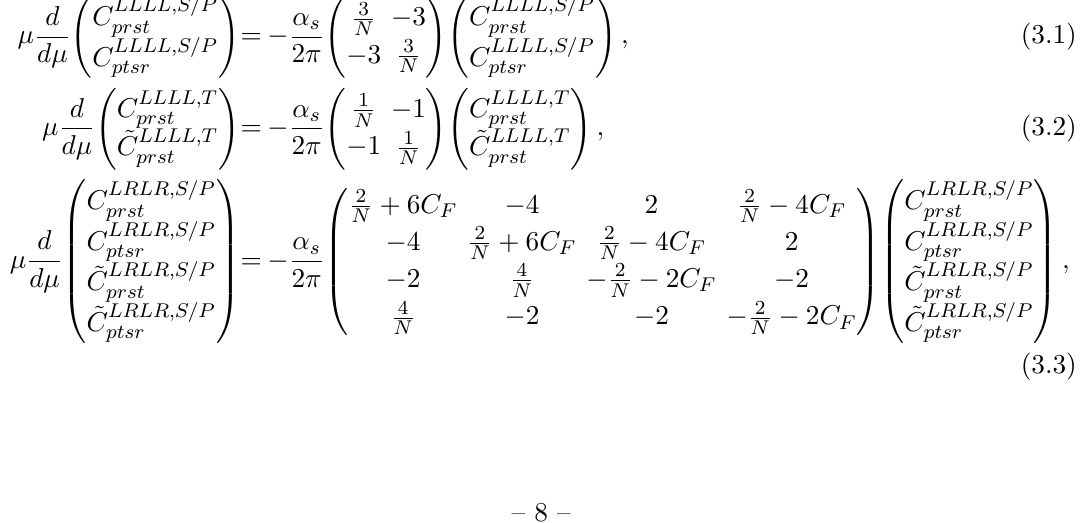
(cid:0) 1 d Y )( u X (cid:0) 2 d Y 1 1 2 2